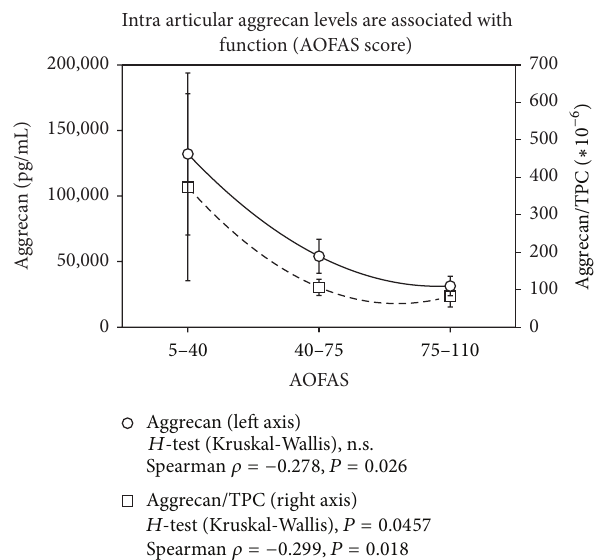
Figure 2: Increasing intra-articular levels of aggrecan are observed with progress of OA measured by a functional score of the ankle (AOFAS). Results of the polynomial regression analysis, the Spearman correlation, and the post hoc statistics (Kruskal-Wallis H - Test) are indicated for absolute aggrecan levels and concentrations in relation to the total protein content (TPC) on the bottom. Polynomial regression with degree of 2 gives an 𝑅 2 = 1 for absolute and for relative concentrations; values are shown with ± SEM.